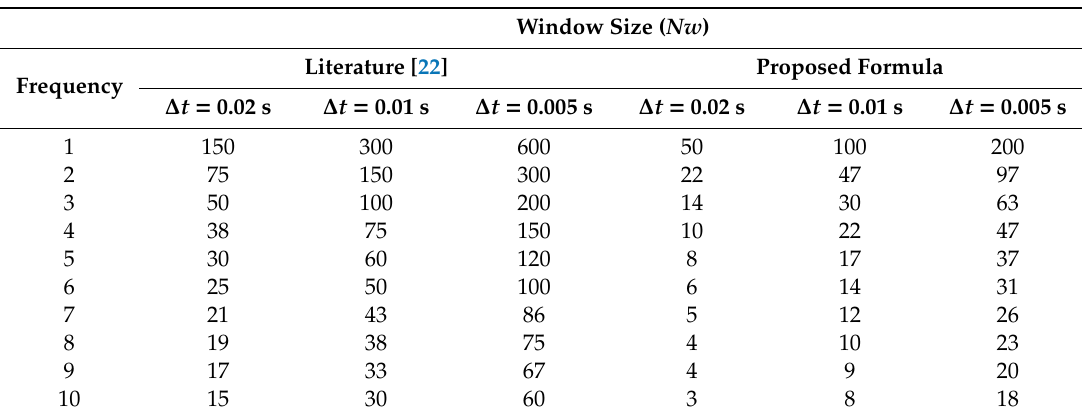
Table 3. Comparison of window size ( N w ) between the proposed and the literature methods [22].